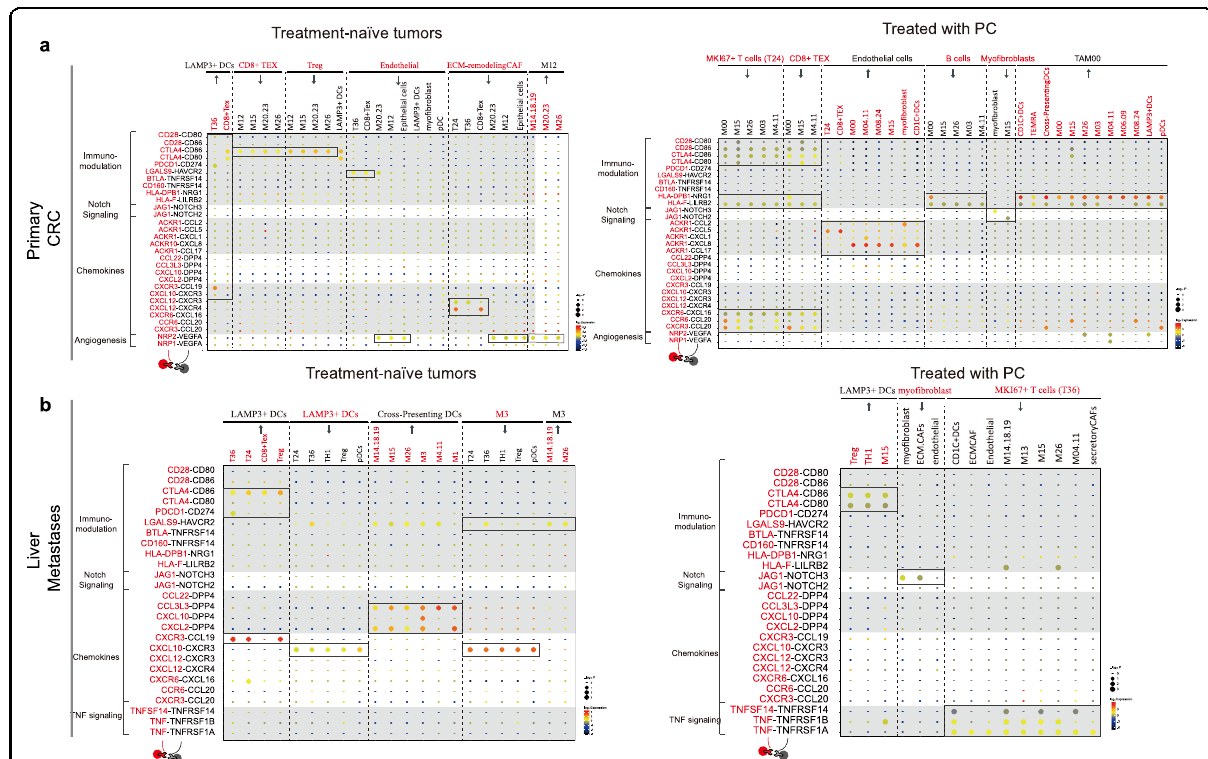
Fig. 6 Cell – cell interaction networks in primary tumors and liver metastases of CRC. a Dot plot depicting the selected LR interactions enriched in treatment-naïve (left) and PC-treated (right) primary CRC tumors. Color intensity corresponds to the mean of average expression; dot size indicates the P values. Scales are shown on the right. b Dot plot depicting the selected LR interactions enriched in treatment-naïve tumors (left) and tumors treated with PC (right) in liver metastases. Two colors (red and black) are used to distinguish the cellular origin of each